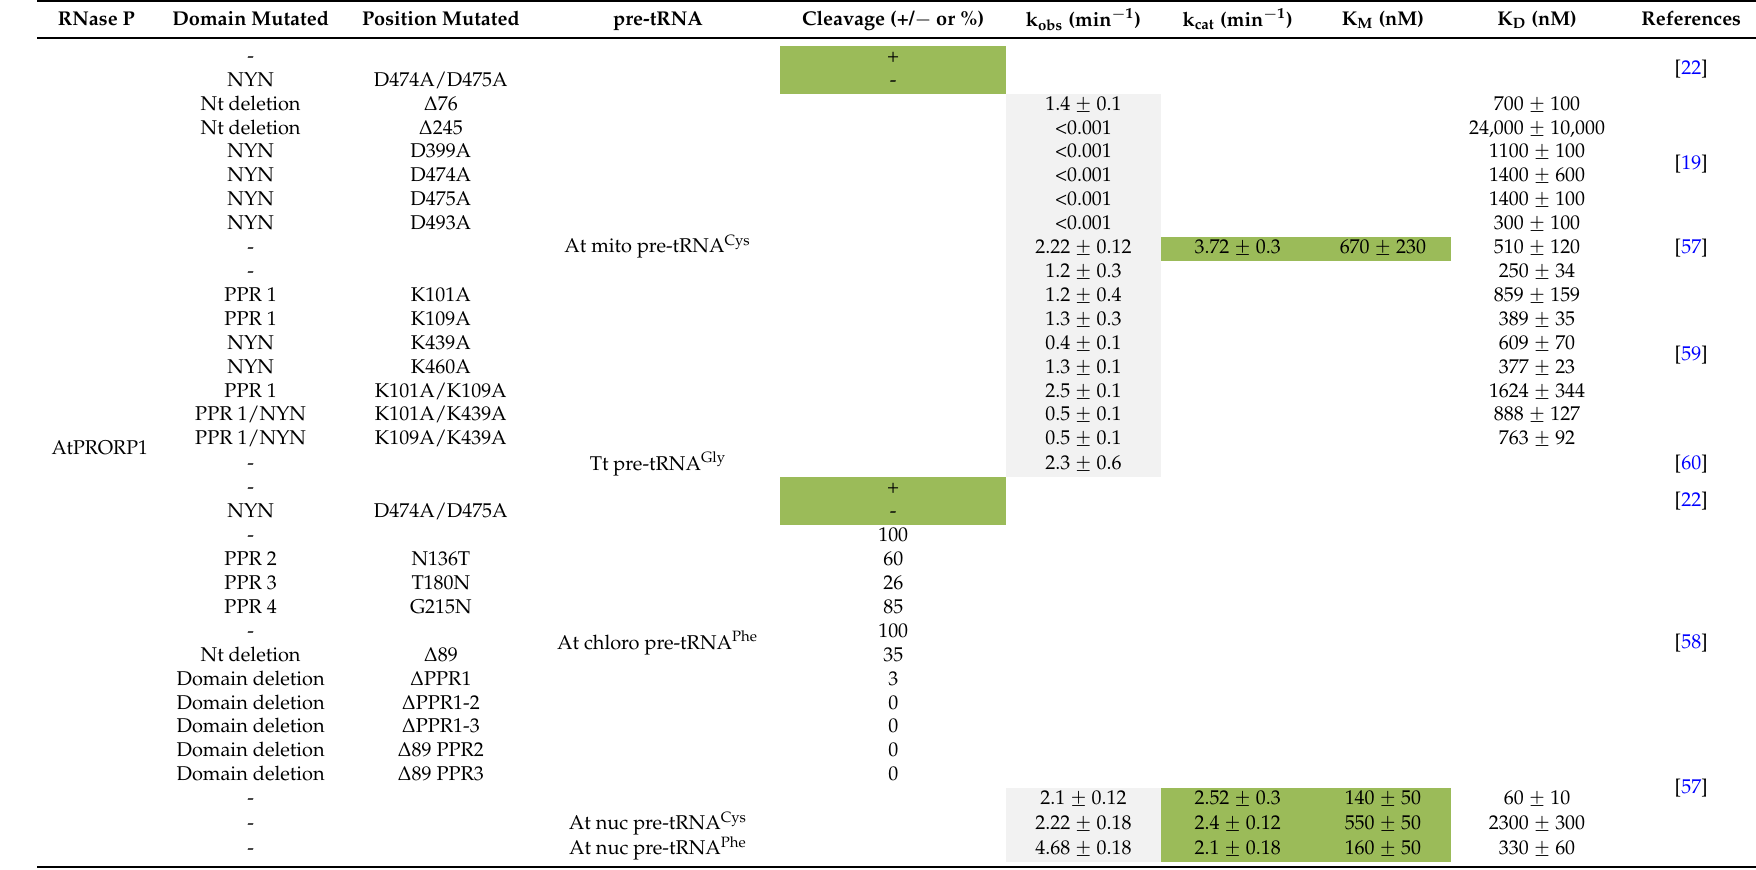
Table 1. Kinetic analyses of the importance of PRORP cis -elements for RNase P activity. At stands for Arabidopsis thaliana , Tt for Thermus thermophilus , “mito” for mitochondrial, “chloro” for chloroplastic, “nuc” for nuclear and “NA” for not applicable in the case of a leaderless RNA substrate. Grey boxes indicate results of single turnover kinetic experiments (with k obs , the observed first order constant obtained by the fit of a single exponential equation), whereas green boxes indicate results of RNase P cleavage assays performed in multiple turnover conditions (with k cat and K M , the Michaelis-Menten parameters). K D were derived from fluorescence polarization binding